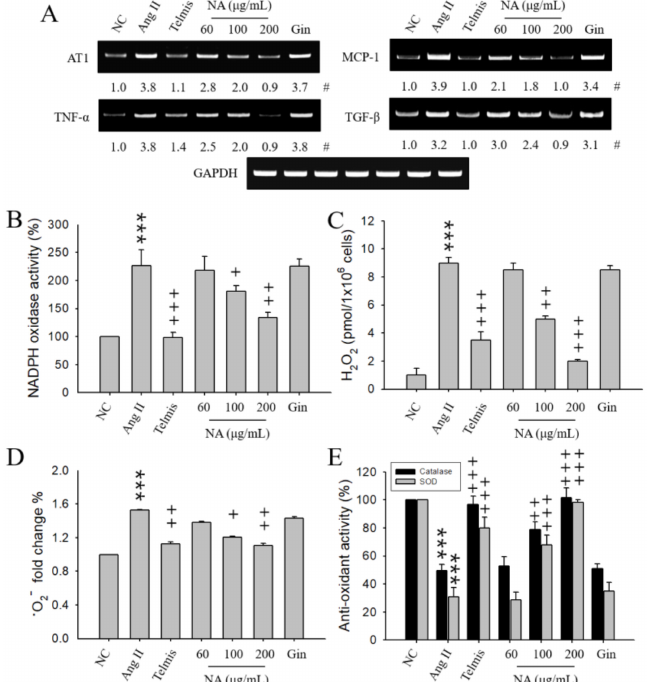
Figure 1. Effects of the natural product mixture (No-ap, NA) on the expression of hypertension-related molecules or oxidative stress in the Ang II-stimulated H9C2 cells. H9C2 cells (1 × 10 6 cells) were stimulated with 300 nM Ang II for 7 h. No-ap (NA), telmisartan (Telmis), or ginsenoside (Gin) were administered 1 h before Ang II stimulation. The expression of AT1, TNF- α , MCP-1, TGF- β was determined in mRNA extracts isolated from H9C2 cells using RT-PCR. The activity of NADPH oxidase,